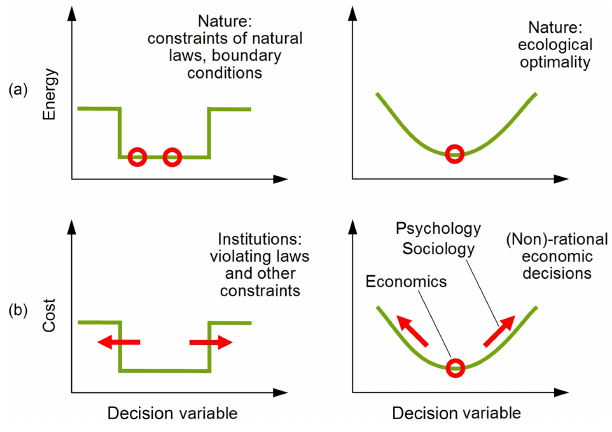
Figure 7. (a) Natural systems follow constraints and optimality laws; (b) Human systems may violate constraints and make irra- tional decisions away from optimality (taken from Sivapalan and Blöschl,